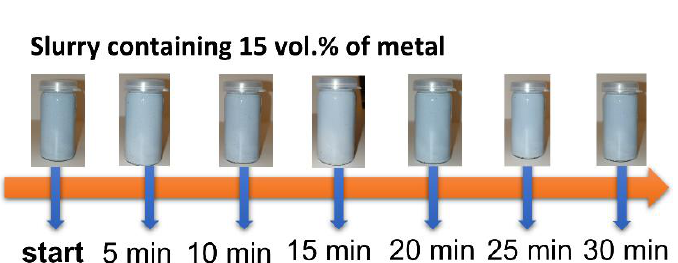
340 Figure 6. Viscosity curves of suspensions.